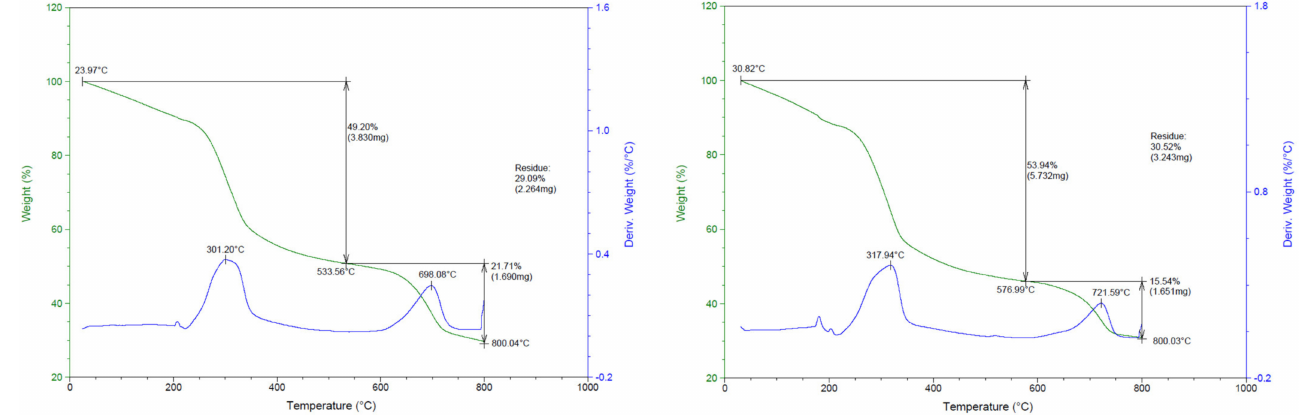
Figure 3. TGA scans of biodegradable containers made from pork skin gelatin, walnut shells, and